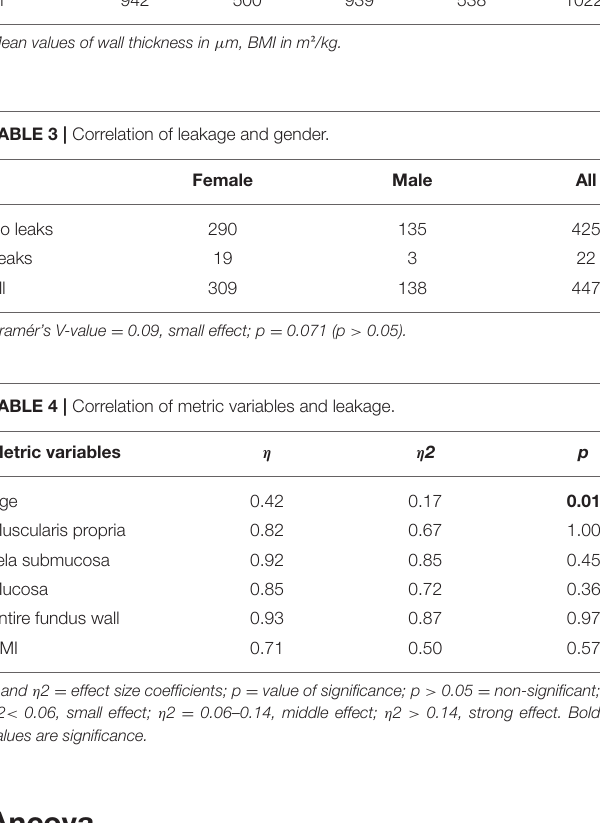
Mean values of wall thickness in µ m, BMI in m ² /kg.